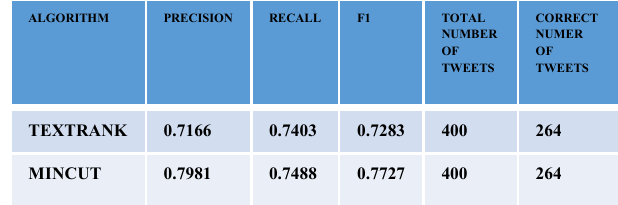
Table 4. Comparison between Min-cut and Text Rank